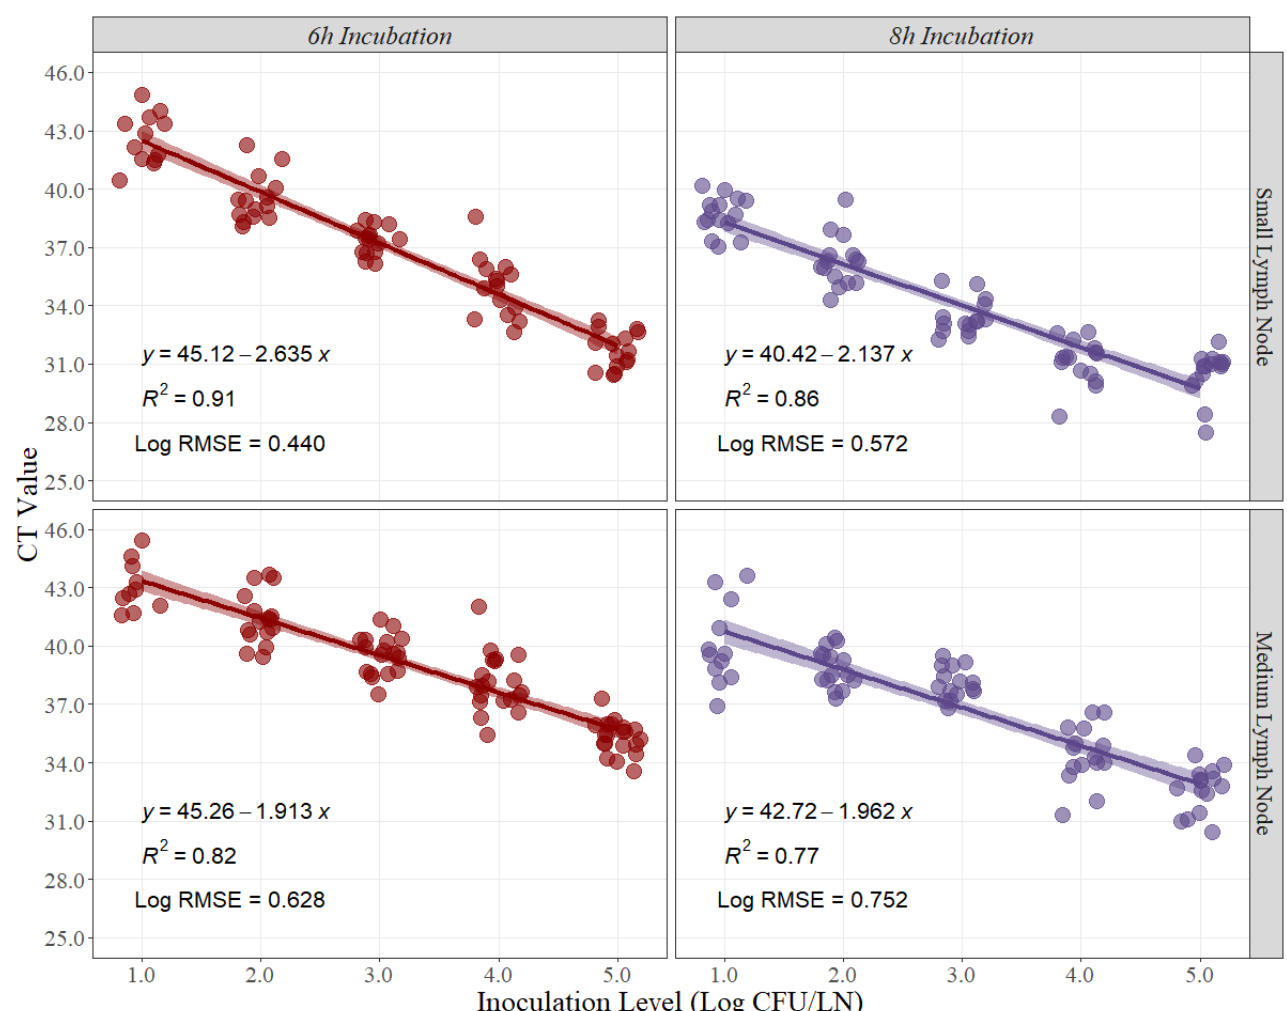
Figure 2. Linear regression for curve development of small and medium beef lymph nodes at 6 h and 8 h of recovery time, comparing cycle threshold (CT) values and inoculation levels (Log CFU/LN), (n = 15 per inoculation level). A small level of jittering was added to the actual dots for visualization purposes. RMSE = root mean squared error.